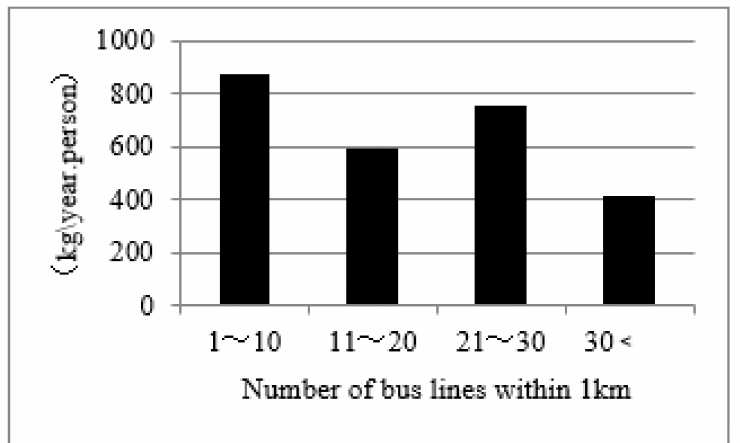
Figure 3. Travel carbon emissions of residents under different ground bus accessibility.